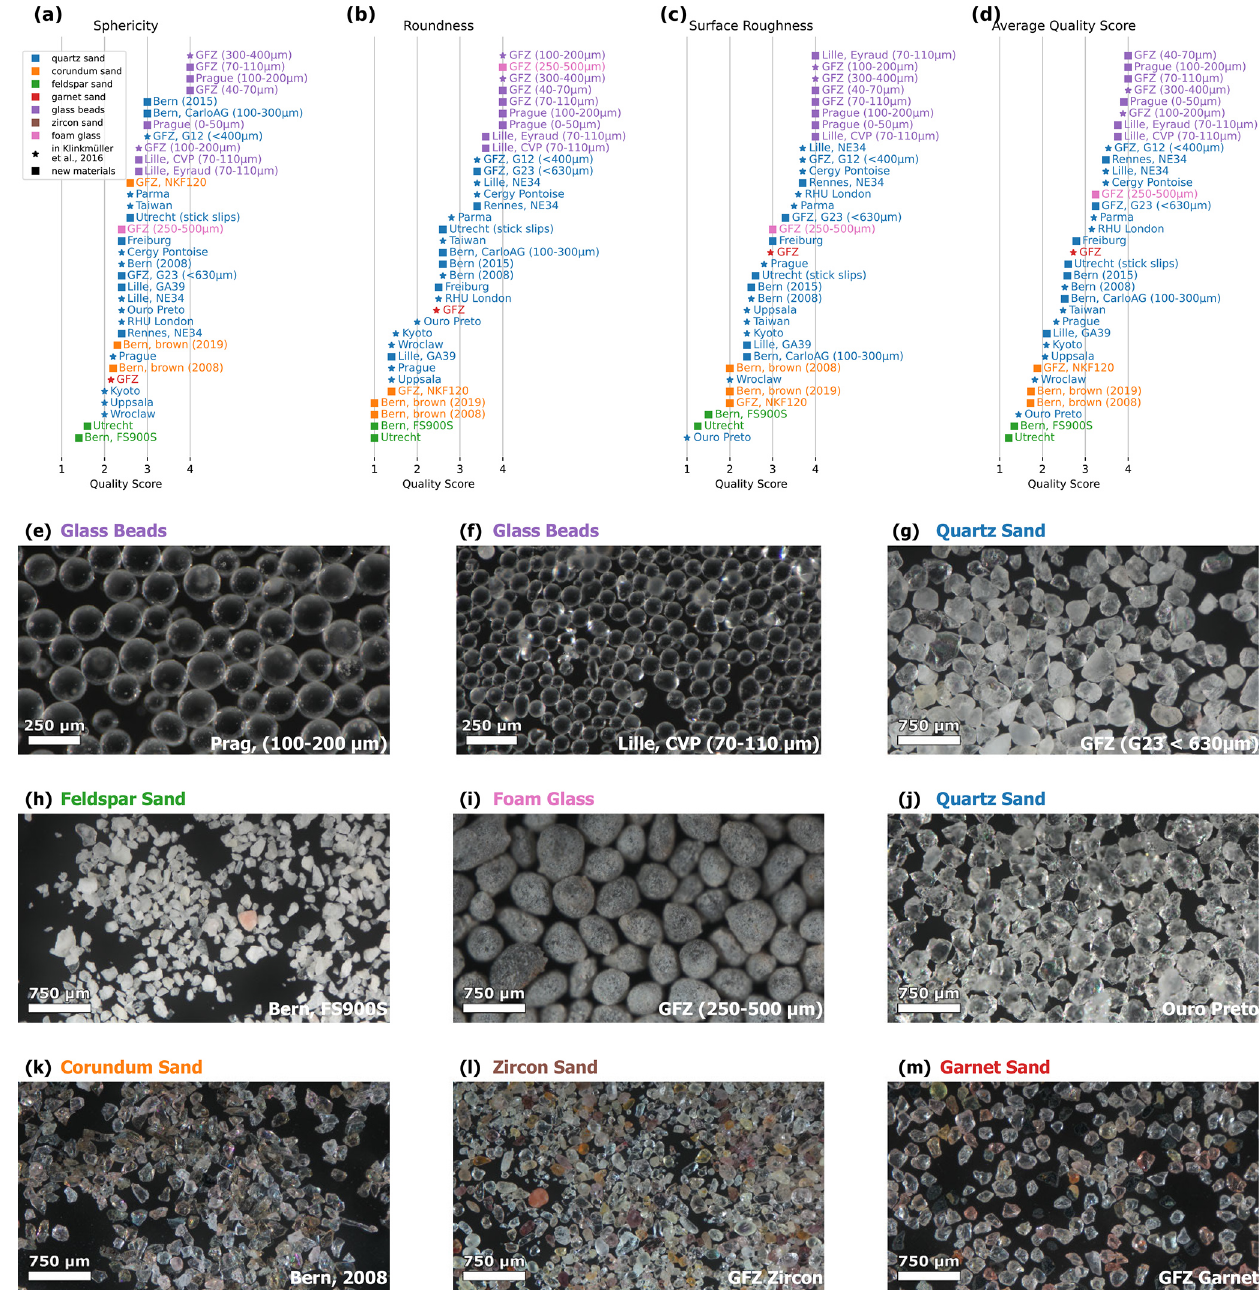
Figure 3. Quality scores and some exemplary materials that show specific characteristics. (a) – (d) Stacked and sorted quality score for the individual properties and weighted average according to Table 2. (e) Glass beads with high sphericity, high roundness and low surface roughness. (f) Glass beads with some low-sphericity grains. (g) Typical quartz sand with medium sphericity, good roundness and low surface roughness (aeolian sand). (h) Feldspar sand with low sphericity, low roundness and high surface roughness. (i) Foam glass with medium sphericity, good roundness and medium surface roughness. (j) Sand with high surface roughness due to shelly and jagged surfaces (crushed sand). (k) Corundum sand with some elongated grains leading to a higher sphericity score. (l) Zircon sand with many elongated and elliptical grains but good roundness. (m) Garnet sand with spherical, subangular grains and high surface roughness due to broken grains.